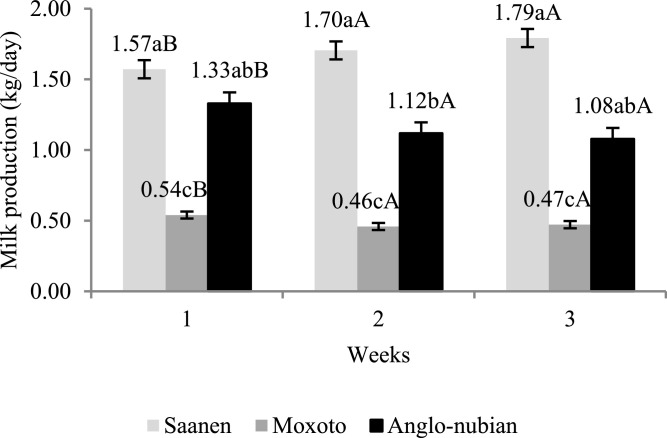
Milk production (kg/day) during the first 3 lactation weeks. Means followed by lowercase letters differ between breeds and averages, with capital letters differing for lactation weeks, according to Tukey's test (P < 0.10).